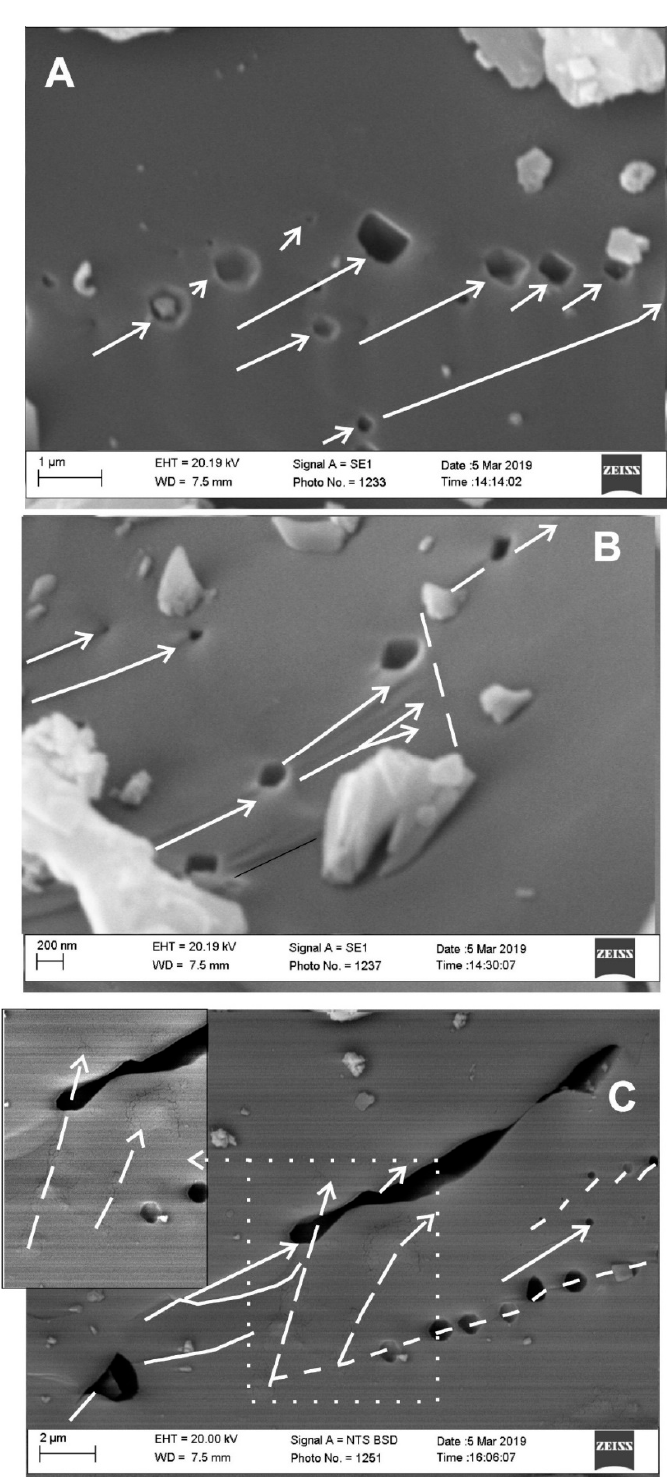
Figure 7. Fractures in the granules at 150–200 MPa; in photo ( A ) the euhedral shapes of the craters at the apex of fractures of a few microns are well observed. Photo ( B ) shows the formation of several generations of fractures starting from the craters. In photo ( C ), there are open fractures formed by the coalescence of the craters that form at the end of the fractures; on the left, aligned bubbles, barely visible on the surface of the granules. In white, the apparent directions taken by the fractures, in black the visible directions.